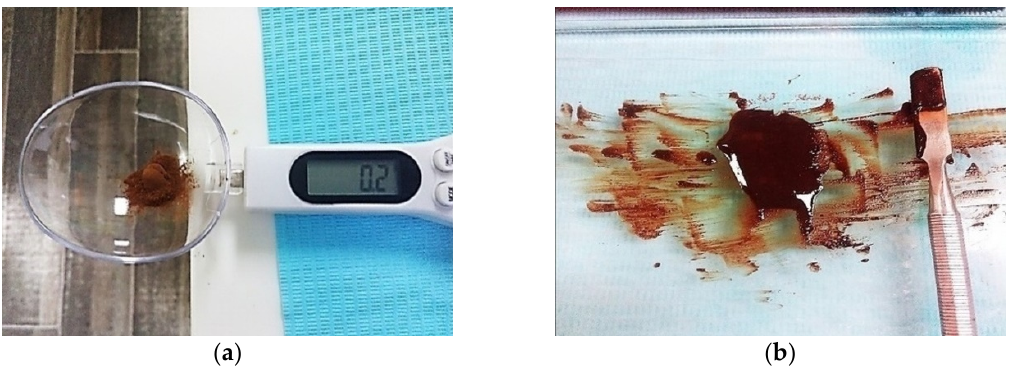
Figure 1. Propolis powder and propolis paste. ( a ) Weighing of propolis powder on a digital spoon scale. A two-scoop-level of (glass ionomer powder dispensing) the plastic spoon corresponded to 200 mg of propolis powder. ( b ) Propolis was mixed with saline to form a